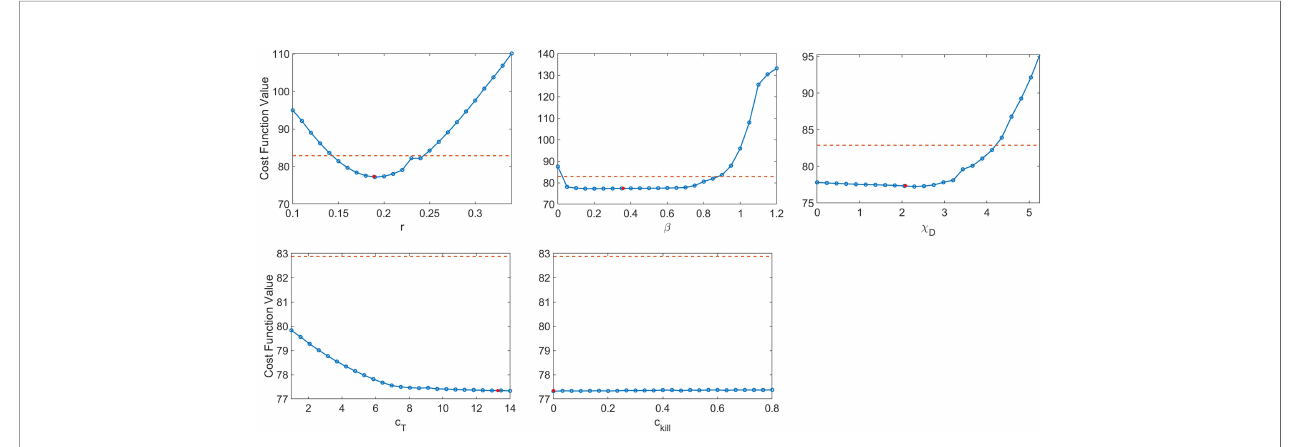
FIGURE 6 | Pro fi le likelihood curves. Top row: tumor growth rate r , infectivity rate b , T cell activation rate by DCs c D . Bottom row: T cell stimulation rate by immunostimulants c T , and rate at which immunostimulants enhance cytotoxicity of T cells c ĸ ill . The threshold (red dashed line) is calculated using df = 5 and a 95% con fi dence